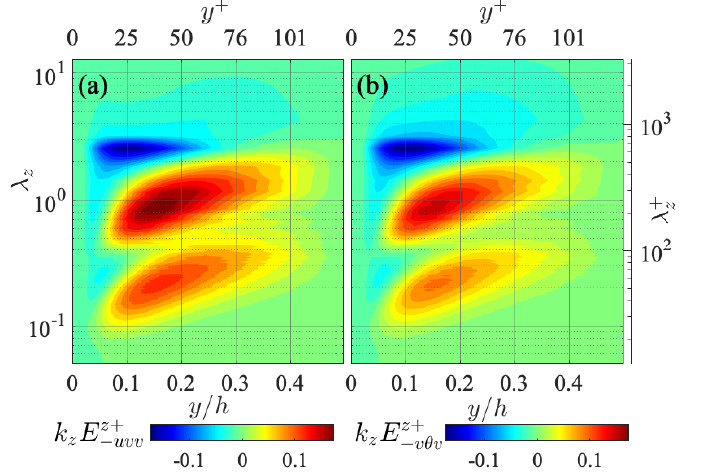
Figure 9. Spanwise one-dimensional premultiplied spectra of turbulent spatial fluxes of ( a ) Reynolds shear stress E z − uvv and ( b ) the turbulent heat flux E z − The values are scaled by u 3 τ and u 2 τ T τ ,